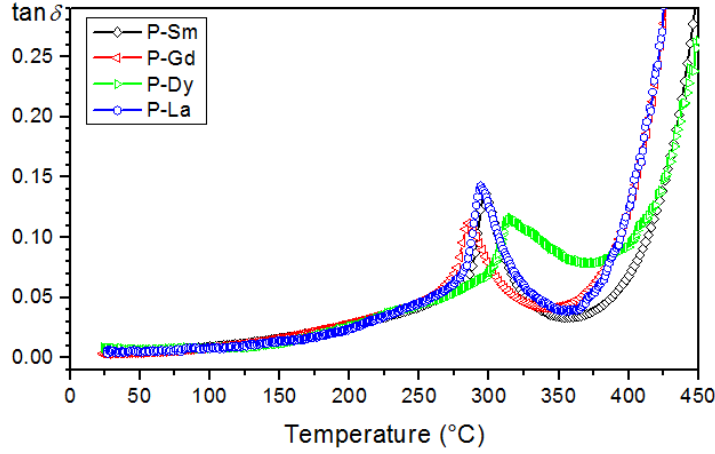
Figure 9. Comparison tan (T) graph for the four multicomponent PZT-type materials (for 1 kHz).